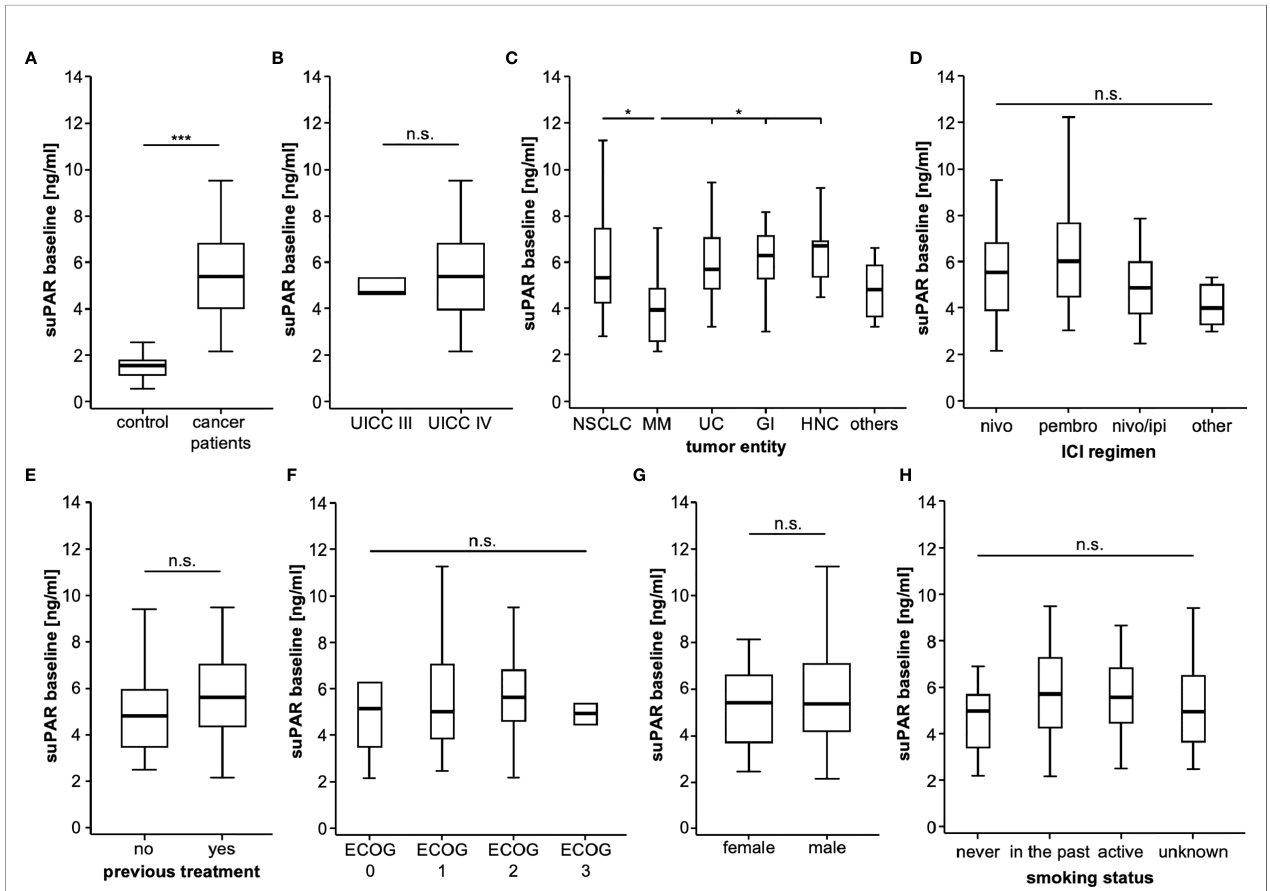
FIGURE 1 | SuPAR serum levels are signi fi cantly increased in cancer patients. (A) SuPAR serum levels are signi fi cantly elevated in cancer patients compared to healthy controls. While baseline suPAR levels are comparable between patients with different tumor stage (B) , patients with malignant melanoma have signi fi cantly lower suPAR levels compared to most other tumor entities (C) . There is no signi fi cant difference in baseline suPAR levels regarding the scheduled ICI regimen (D) as well as between patients who did or did not receive previous systemic cancer therapy (E) . There is no regulation of circulating suPAR with respect to the ECOG performance status (F) , gender (G) or the smoking status (H) n.s. non signi fi cant, *p < 0.05, ***p <